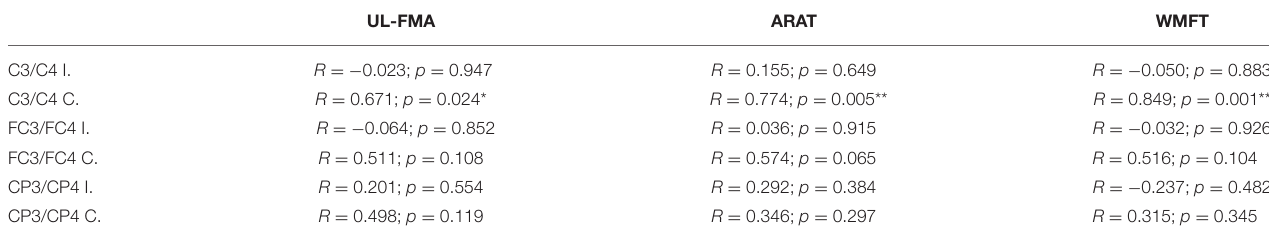
TABLE 3 | Correlations between change in clinical scales (UL-FMA, ARAT, WMFT) and change in EEG fApEn at six electrodes (C3, C4, FC3, FC4, CP3, CP4). UL-FMA ARAT WMFT